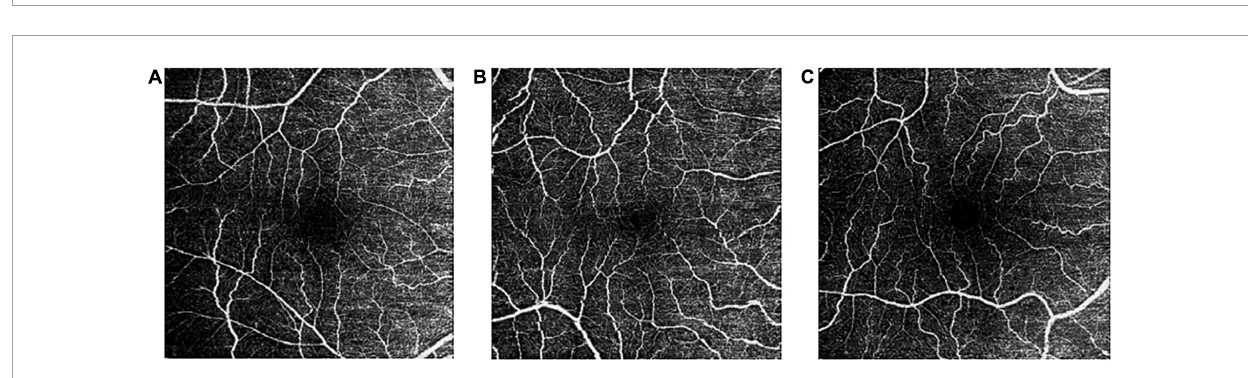
FIGURE3 Representative macular VD images from the superficial vascular plexus for each AT(N) group: Normal (A) , Alzheimer (B) , and SNAP (C) . SNAP, suspected non-Alzheimer pathology; VD, vessel